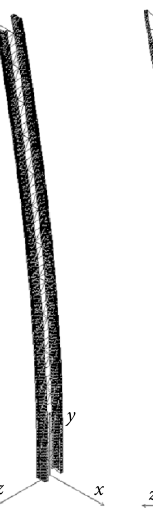
Fig. 5. The mode of the flexural buckling shape of the steel built-up column about axis x-x (in-plane)